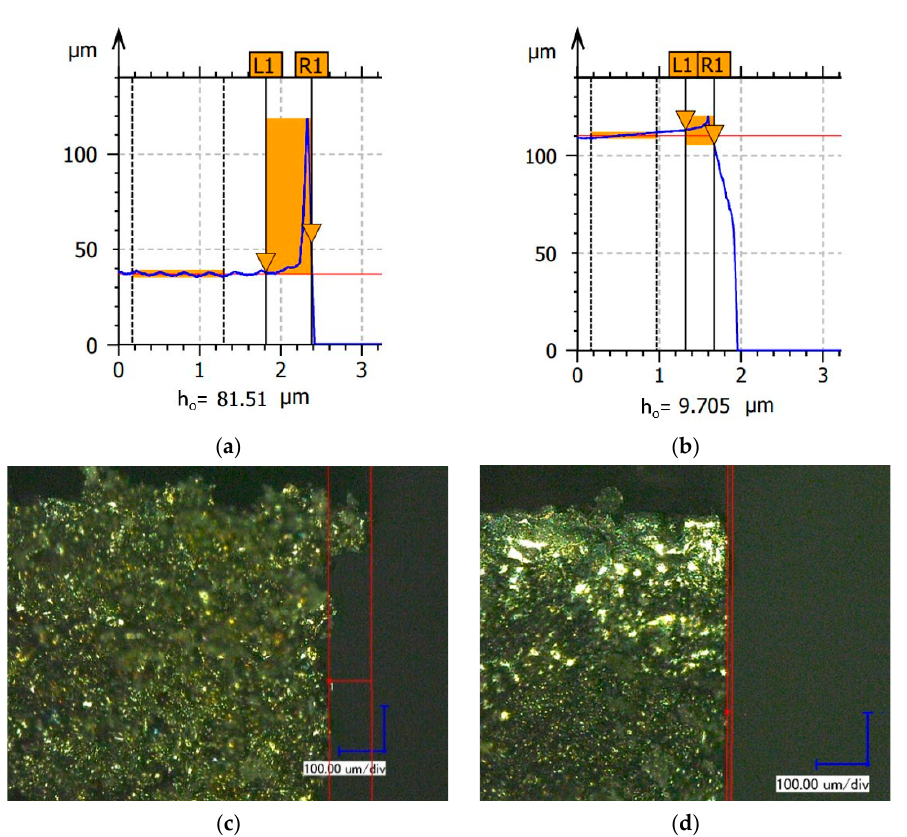
Figure 4. Burr height measurement result—primary burr ( a , c ) and secondary burr ( b , d ). The following parameters were used in the experimental studies: length l , width d , height h , and clearance angle α , which were 9.8, 5.5, 3.2 mm, and 8°, respectively. Three different values of tool rake angle γ were used in the experiments (8, 16, 24°), and three values of angle ω (10, 20, 45°). Nine inserts were made with different γ and ω parameters (Table 4). A photograph of all inserts is shown in Figure 5.